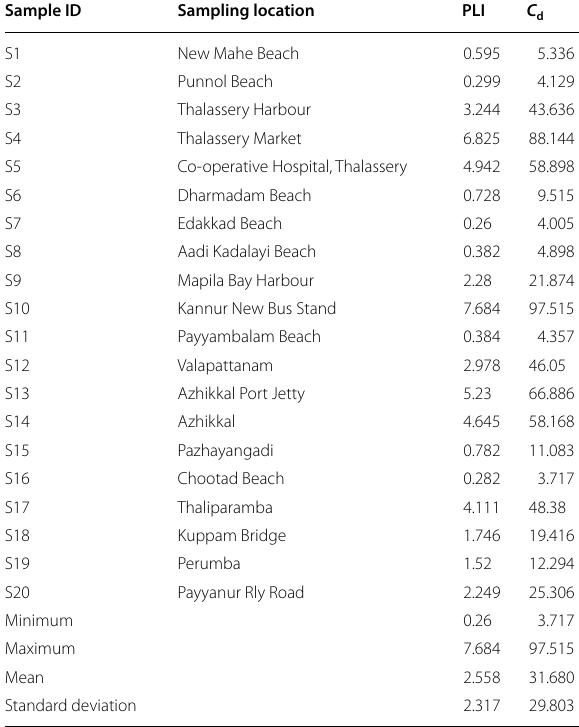
Table 11 Pollution load index and degree of